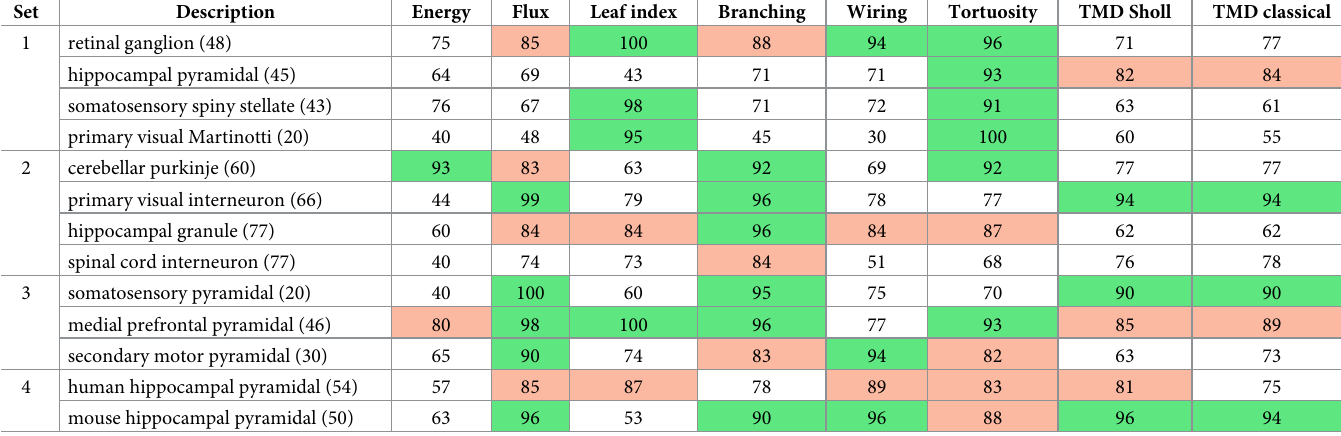
Table 1. Detection rates applied to all datasets based on all descriptors. Numbers represent percentages. Green represents complete detection of a class (90%-100%), while pink represents detection rates between 80%-89%.